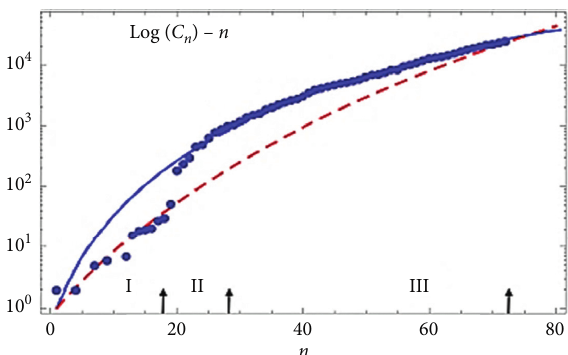
n cases with days n